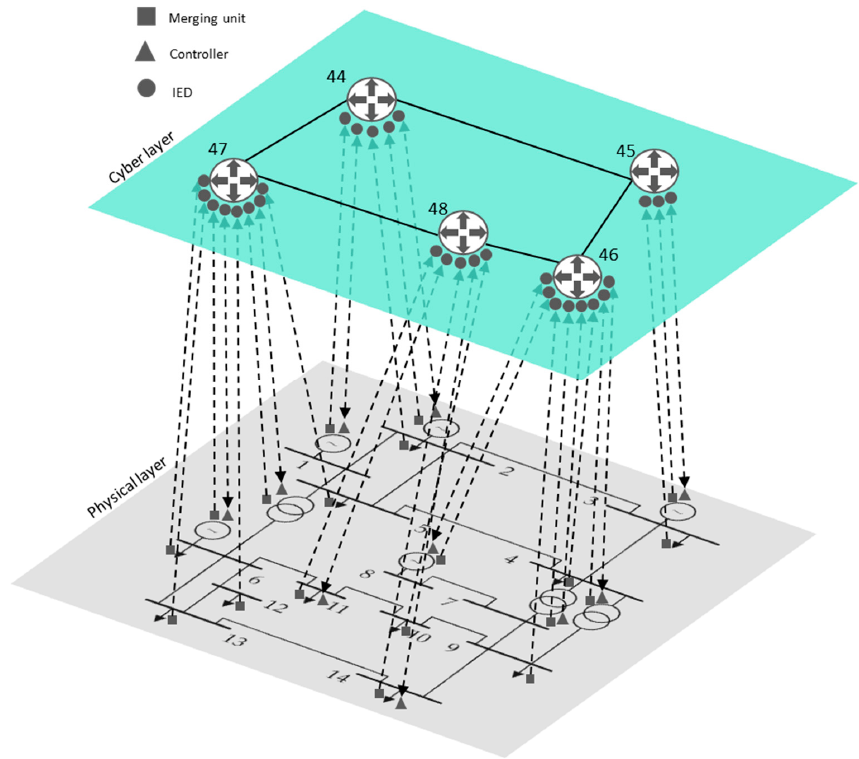
Figure 5. A cyber-physical representation of the modified IEEE 14-bus test case.